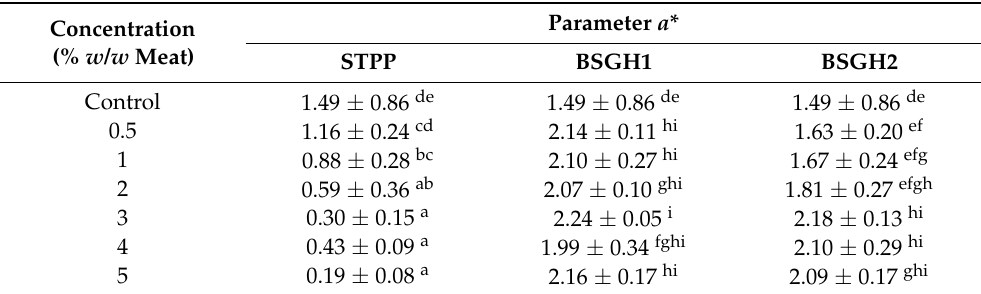
Table 3. Average values of the color parameter a * for STPP, BSGH1, and BSGH2. Results are presented as the average of three replicates ± standard deviation. Different letters indicate significant differences ( p ≤ 0.05).